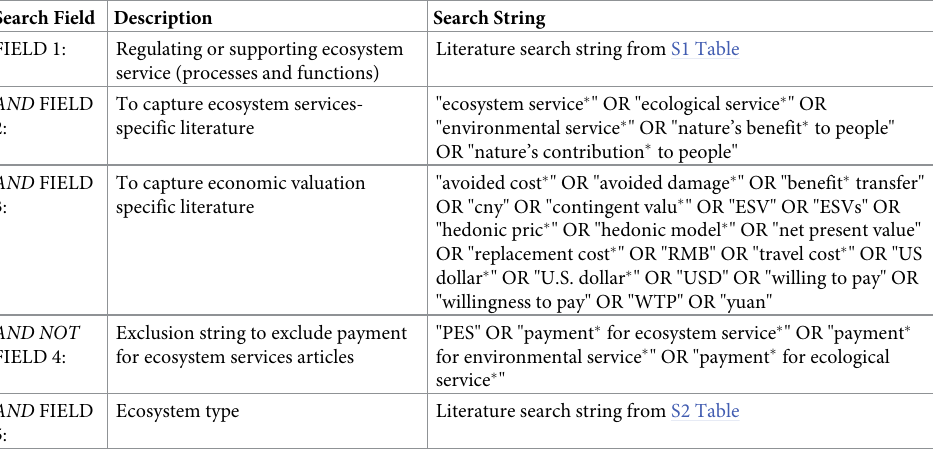
Table 2. Search fields and associated search stings for retrieving economic valuation research on regulating and supporting ecosystem services from Web of Science and Scopus.